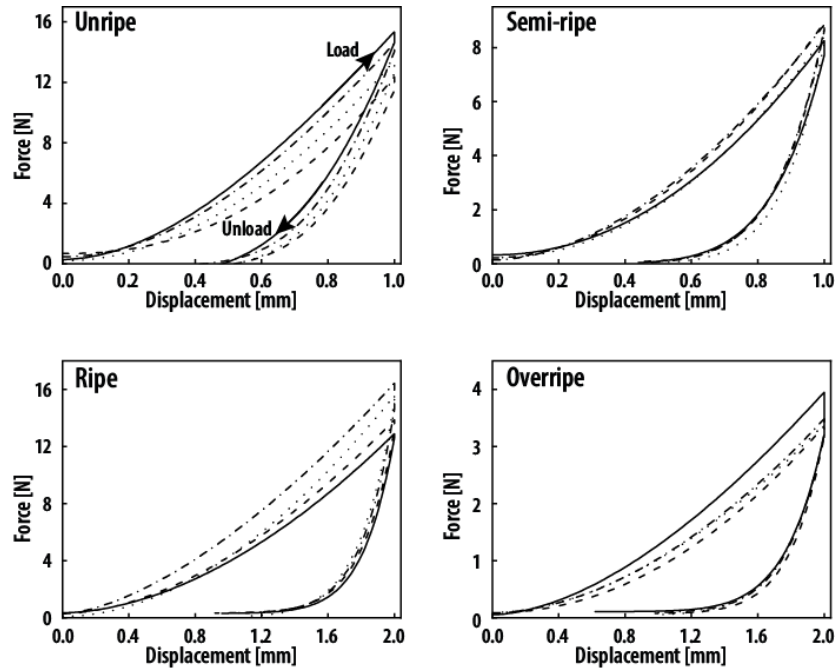
Figure 3. Loading and unloading curves for the exocarp–mesocarp. Dashed lines represent other samples.